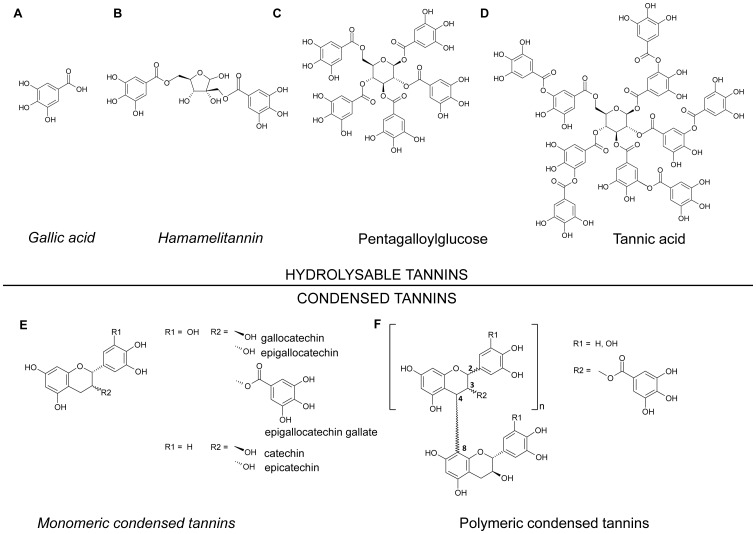
Chemical structures of tannins and pseudotannins in Hamamelis virginiana L.(A) gallic acid, (B) hamamelitannin, (C) pentagalloylglucose, (D) tannic acid represented with 10 galloylation units, (E) monomeric condensed tannins, (F) polymeric condensed tannins [48]. Pseudotannins having low or no protein precipitating activity (and molecular weights <500 g/mol) are shown in italics.